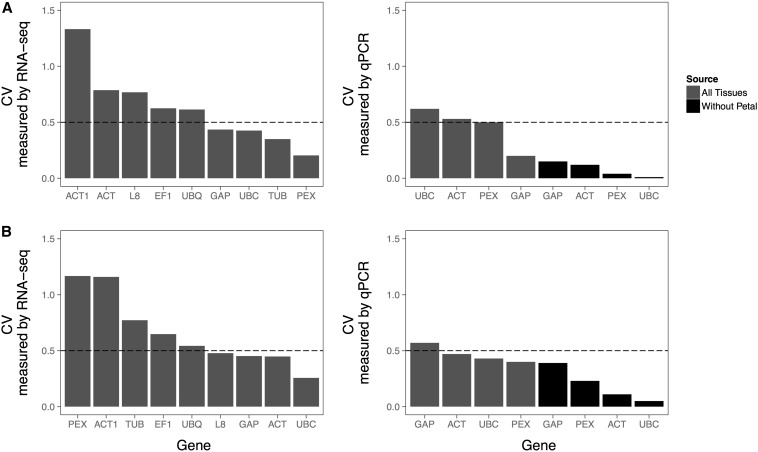
Expression variability estimates for selected traditional reference genes, based on coefficient of variation (CV). Expression variability in M. guttatus (A) and M. l. luteus (B) measured via RNA sequencing (RNA-seq) on both T1 and T2 (left column) or via quantitative polymerase chain reaction (qPCR) on T2 samples only (right column). Gray bars show the calculated CV when all tissue types are included and black bars show the calculated CV when petal tissue is excluded. Genes are ordered from most variable to least variable, with a dash line showing a previously suggested cut-off for usable reference genes at 0.50 CV. For the tetraploid M. l. luteus, CVs reported for the RNA-seq data are the average of both homeologs. The genes tested include 60s ribosomal protein L8 (L8), actin 2/7 (ACT), actin 11 (ACT1), β-tubulin 2 (TUB), ubiquitin 5 (UBQ), ubiquitin conjugating enzyme 25 (UBC), peroxin 4 (PEX), GAPDH-C1 (GAP), and EF1-α (EF1). CV was calculated from fragments per kilobase per million reads values for genes measured via RNA-seq and from relative expression values, calculated by EfficiencyΔCq, where ΔCq = CqCalibrator – Cqsample, for genes measured via qPCR.